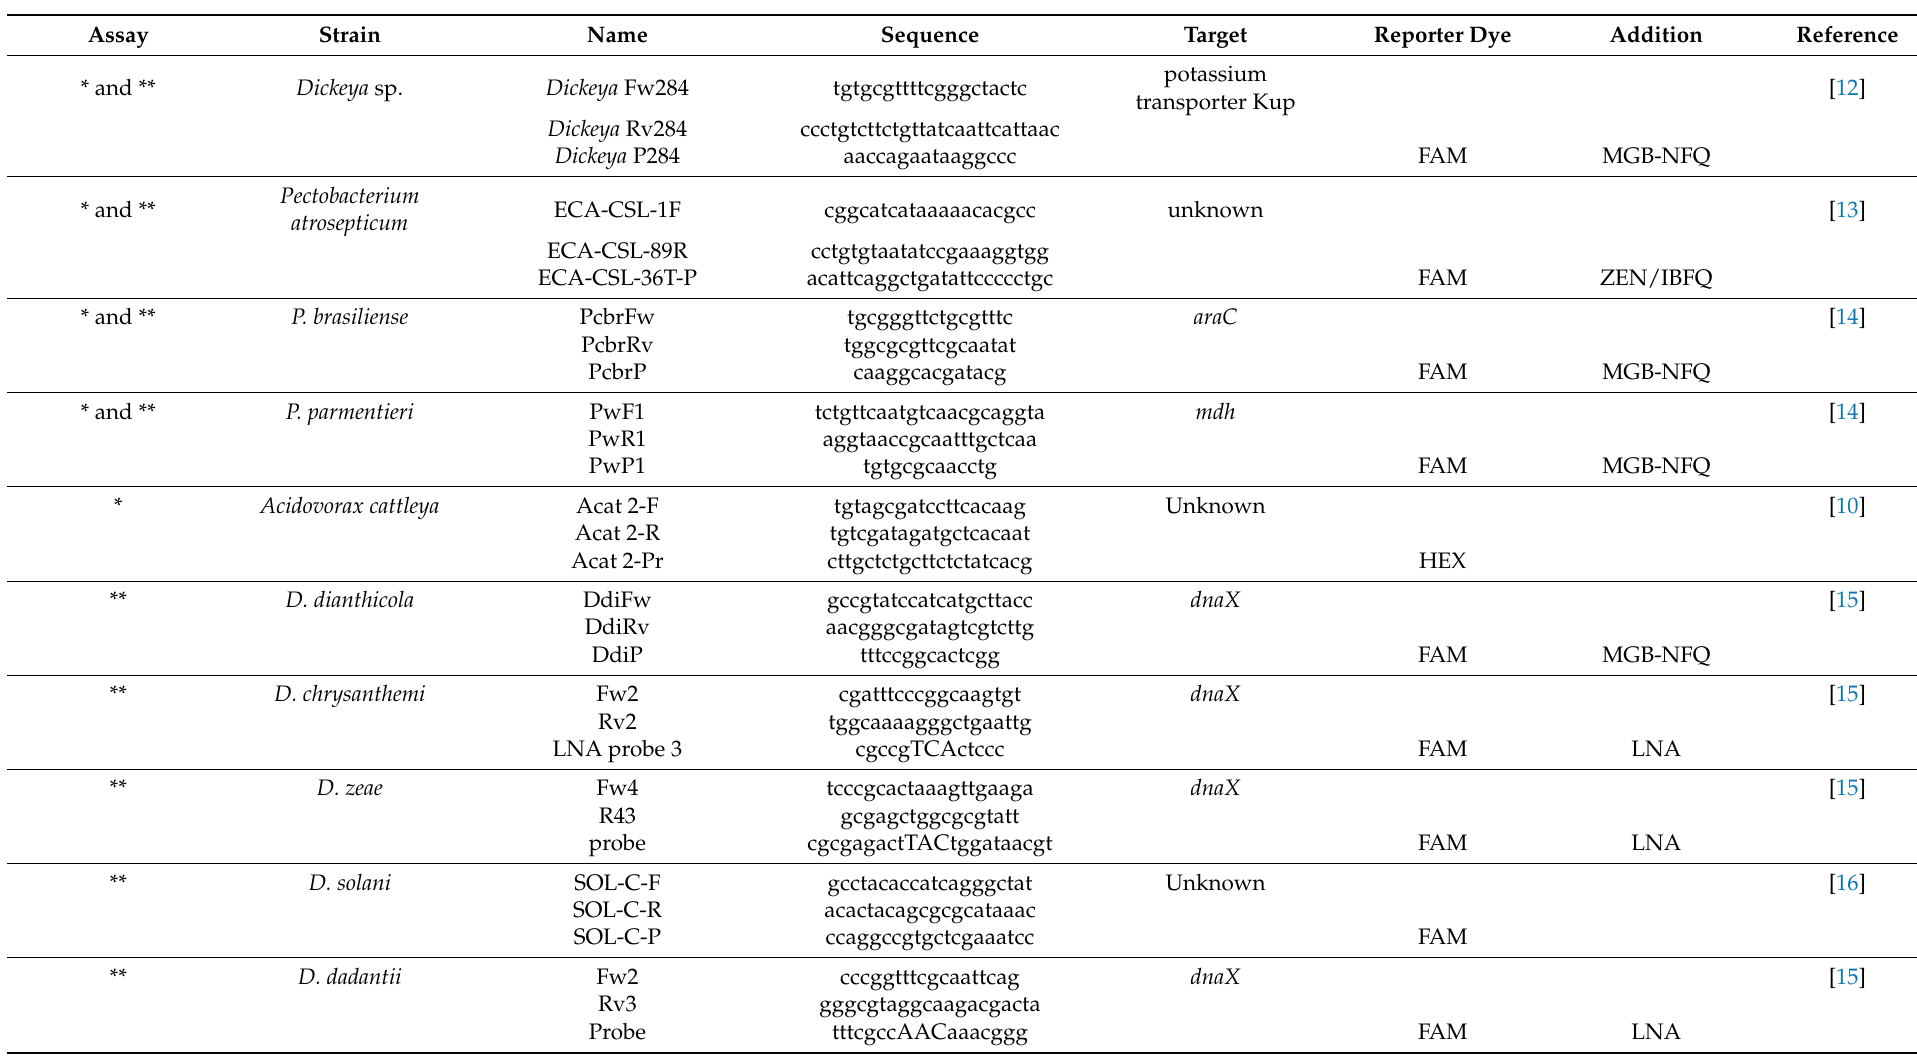
Table 2. Primers and probes used in this